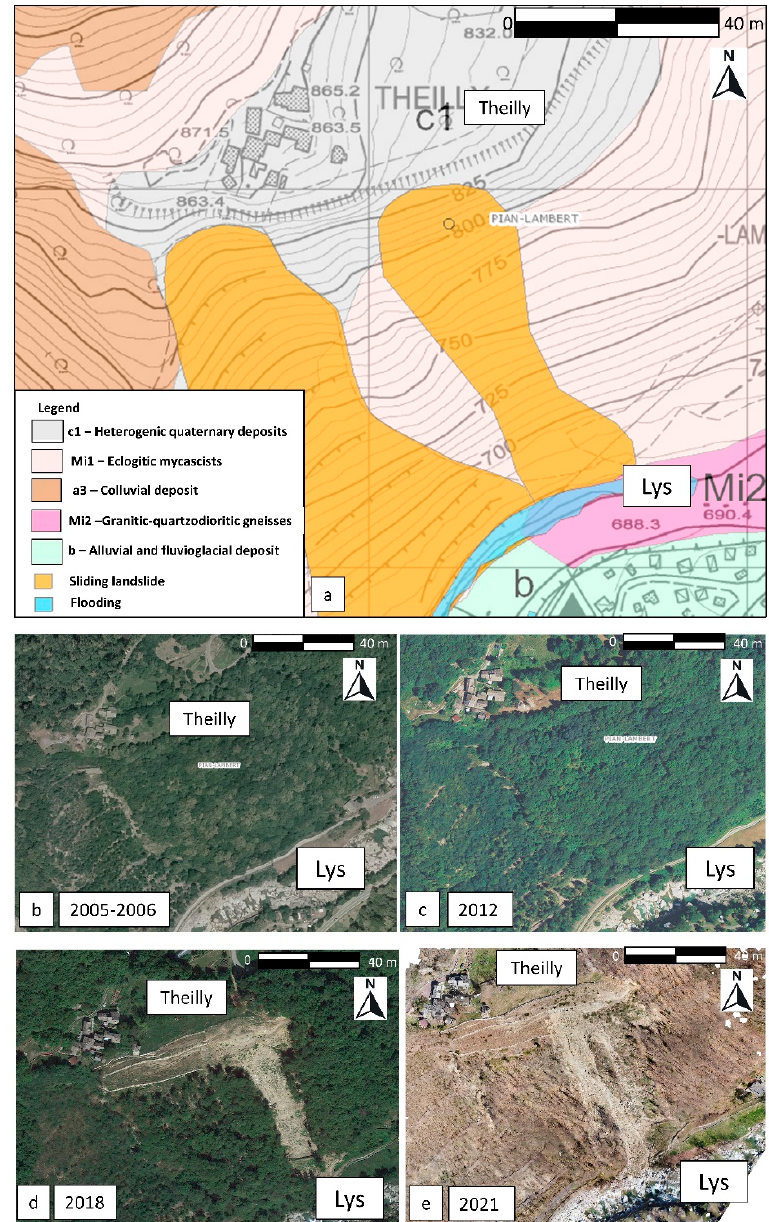
Figure 1. ( a ) Geological map (retrieved from [47](accessed on19 January 2023)) of the Theilly landslide (AO, Italy); ( b ) 2005–2006 aerial image of Theilly slope; ( c ) 2012 aerial image of Theilly slope; ( d ) 2018 aerial image of Theilly slope; ( e ) 2021 aerial image of Theilly slope. Source of the aerial images: [47].